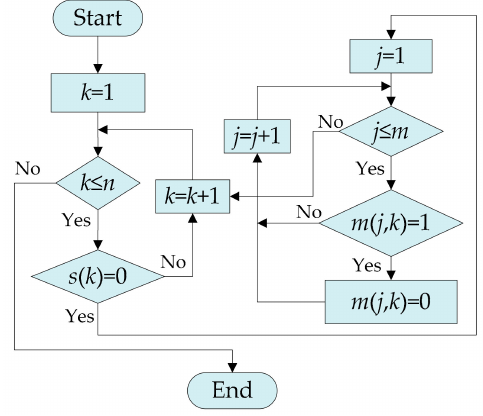
Figure 2. Modification of the original network description matrix M o